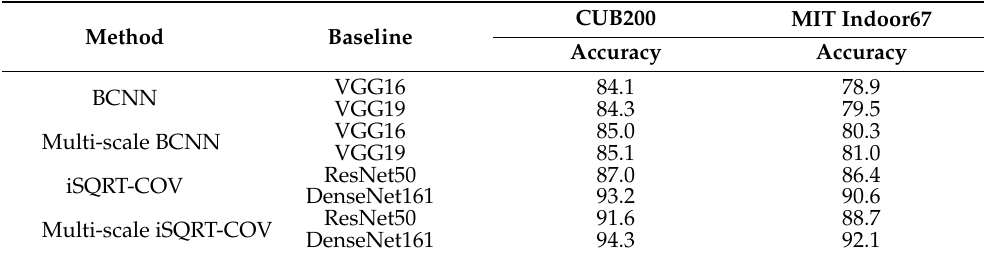
Table 5. Comparison between BCNN and iSQRT-COV. The first column lists different methods of fine-grained classification. The second column shows the baseline. The third and fourth columns list the classification results corresponding to each dataset.